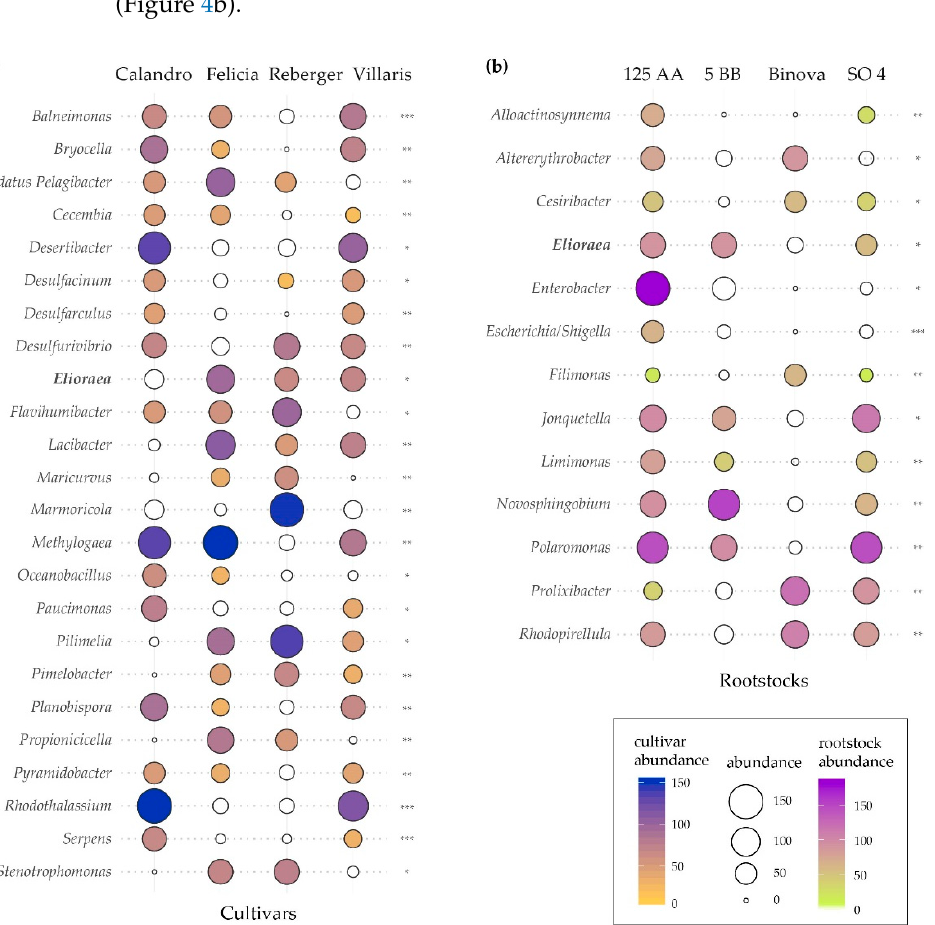
to sequence abundance per genus, bubbles without color indicate that the genus was not an indicator for that particular